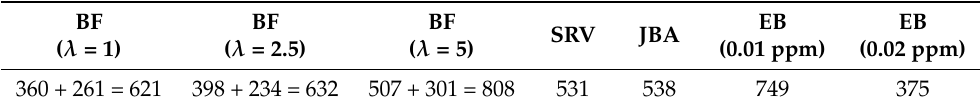
Table 1. The number of metabolite features that were extracted from the 1D 1 H NMR spectra of 223 plasma samples from the GCKD cohort using different binning approaches. The BF results are presented in the form “number of plateau regions + number non-plateau regions = number of